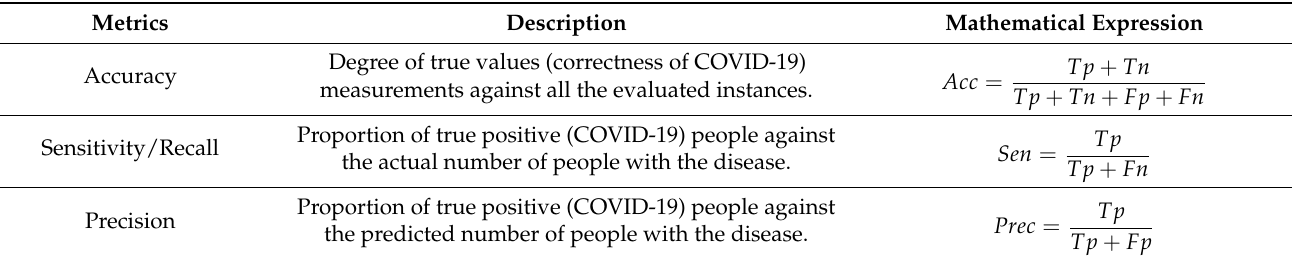
Table 5. Summary of the Evaluation